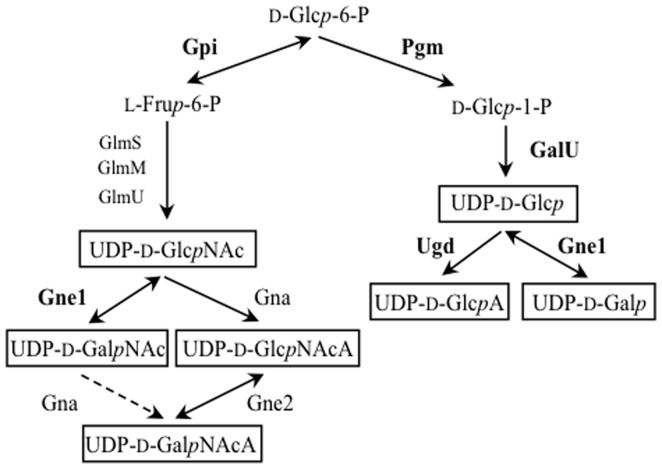
Pathways for biosynthesis of common UDP-linked sugar precursors.Common UDP-linked sugar precursors derived from glucose-6-phophate are boxed. Arrows denote the direction of each reaction, and the enzyme name is adjacent. Enzymes highlighted in bold are encoded by genes in module B (Figure 3). Abbreviations: UDP-D-GlcpNAc is UDP-N-acetyl-D-glucosamine; UDP-D-Glcp is UDP-D-glucose; UDP-D-GlcpA is UDP-D-glucuronic acid; UDP-D-Galp is UDP-D-galactose; D-Glcp-6-P is glucose-6-phosphate; L-Frup-6-P is fructose-6-phosphate; D-Glcp-1-P is glucose-1-phosphate; UDP-D-GalpNAc is UDP-N-acetyl-D-galactosamine; UDP-D-GlcpNAcA is UDP-N-acetyl-D-glucosaminuronic acid; UDP-D-GalpNAcA is UDP-N-acetyl-D-galactosaminuronic acid.